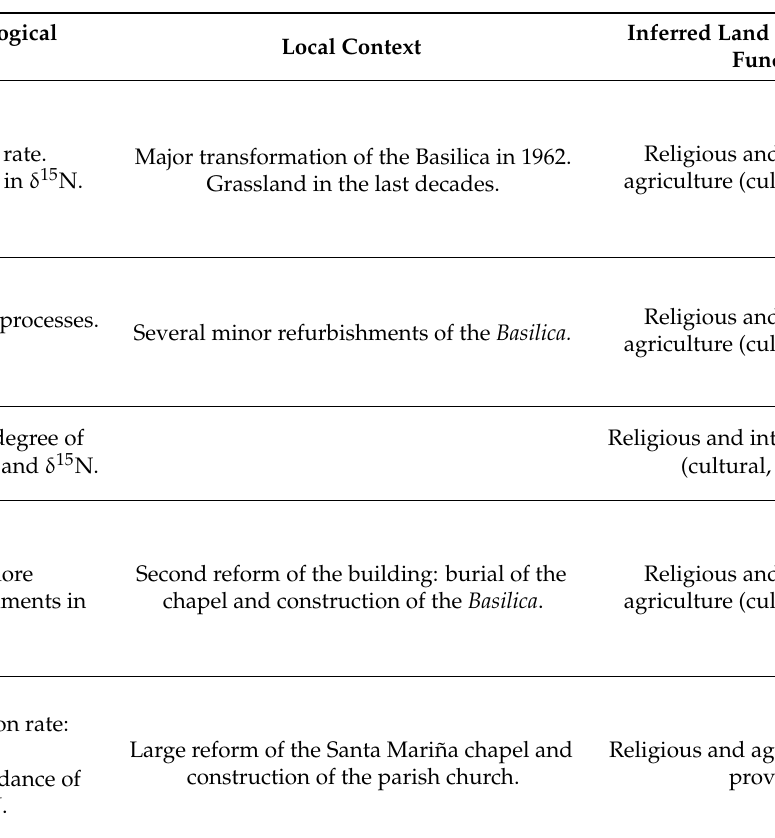
Table 2. Summary of the properties of the core in each of the defined periods and inferred land use and landscape functions. The dashed line represents the sedimentary and chronological